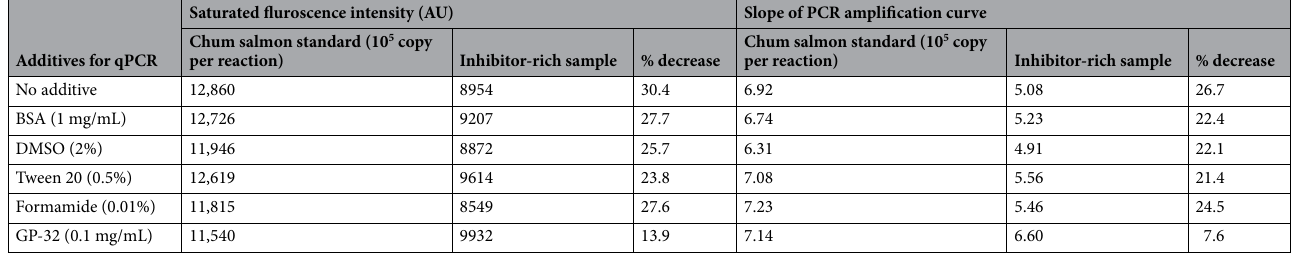
Table 1. Effects of various additives on the real time PCR amplification of a pooled environmental sample rich in inhibitors. Slope of the PCR amplification curve is calculated by linear regression of the steepest